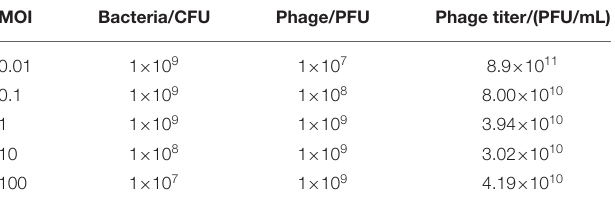
TABLE 2 | Determination of optimal multiplicity of infection (MOI) of vB_Kpn_B01. MOI